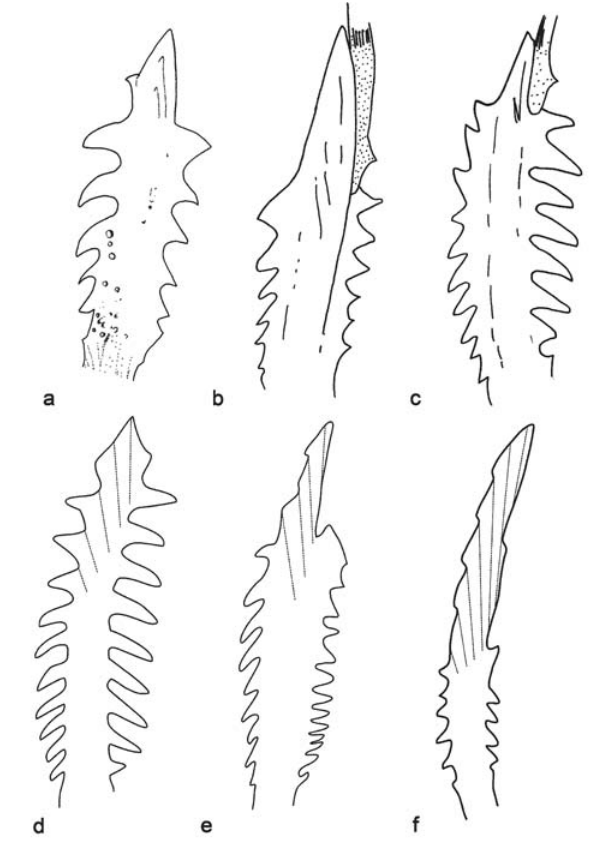
Fig. 6. Pectoral spines in dorsal view of Gladioglanis species and closely related genera. a: Gladioglanis anacanthus , paratype, INPA 28447 (21.5mm SL); b: G. conquistador (30 mm SL); c: G. machadoi (27 mm SL); d: Brachyglanis phalacra , holotype, FMNH 53216 (63.2 mm SL); e: Myoglanis sp., MZUSP 37602 (77.8 mm SL); f: Leptorhamdia essequibensis , INPA 10764 (76.9 mm SL). Illustration of G. machadoi and G. conquistador from Lundberg et al . (1991).